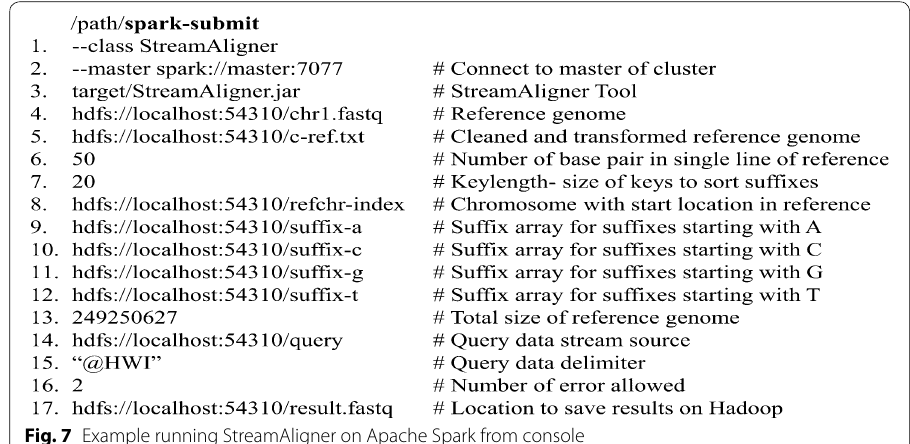
Fig. 7 Example running StreamAligner on Apache Spark from